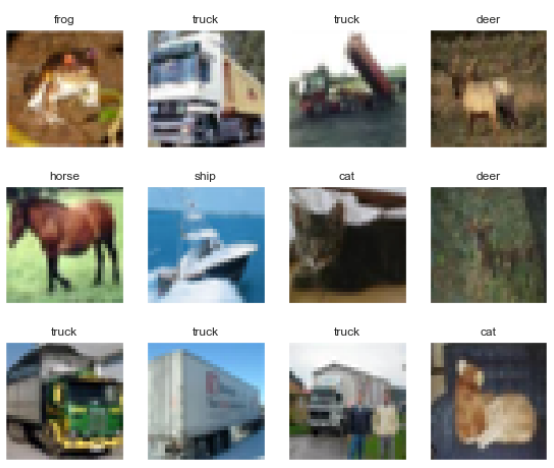
Figure 4. Example visualization of CIFAR-10 colored dataset images.